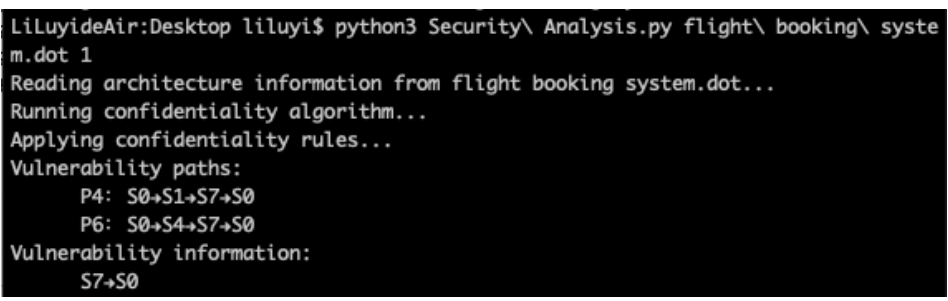
Figure 9. Output of vulnerability determination algorithm under the goal of confidentiality.